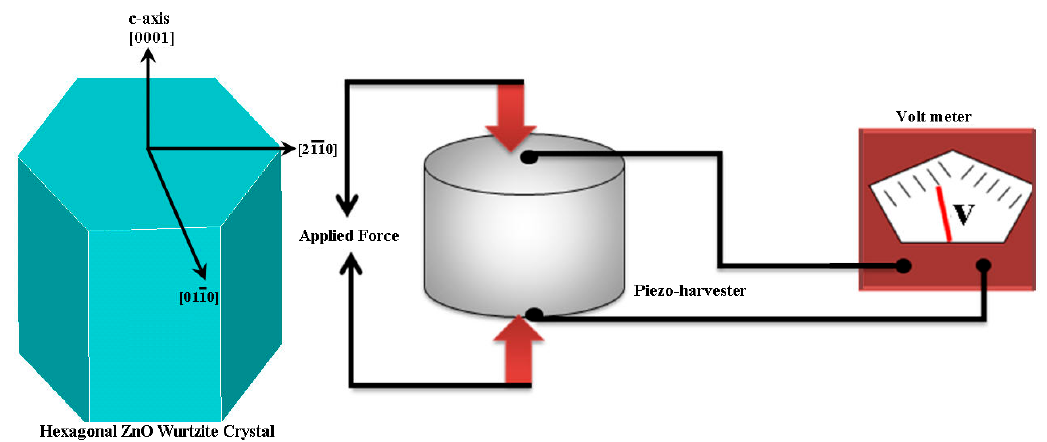
Figure 1. The basic working principle of a piezoelectric harvester.